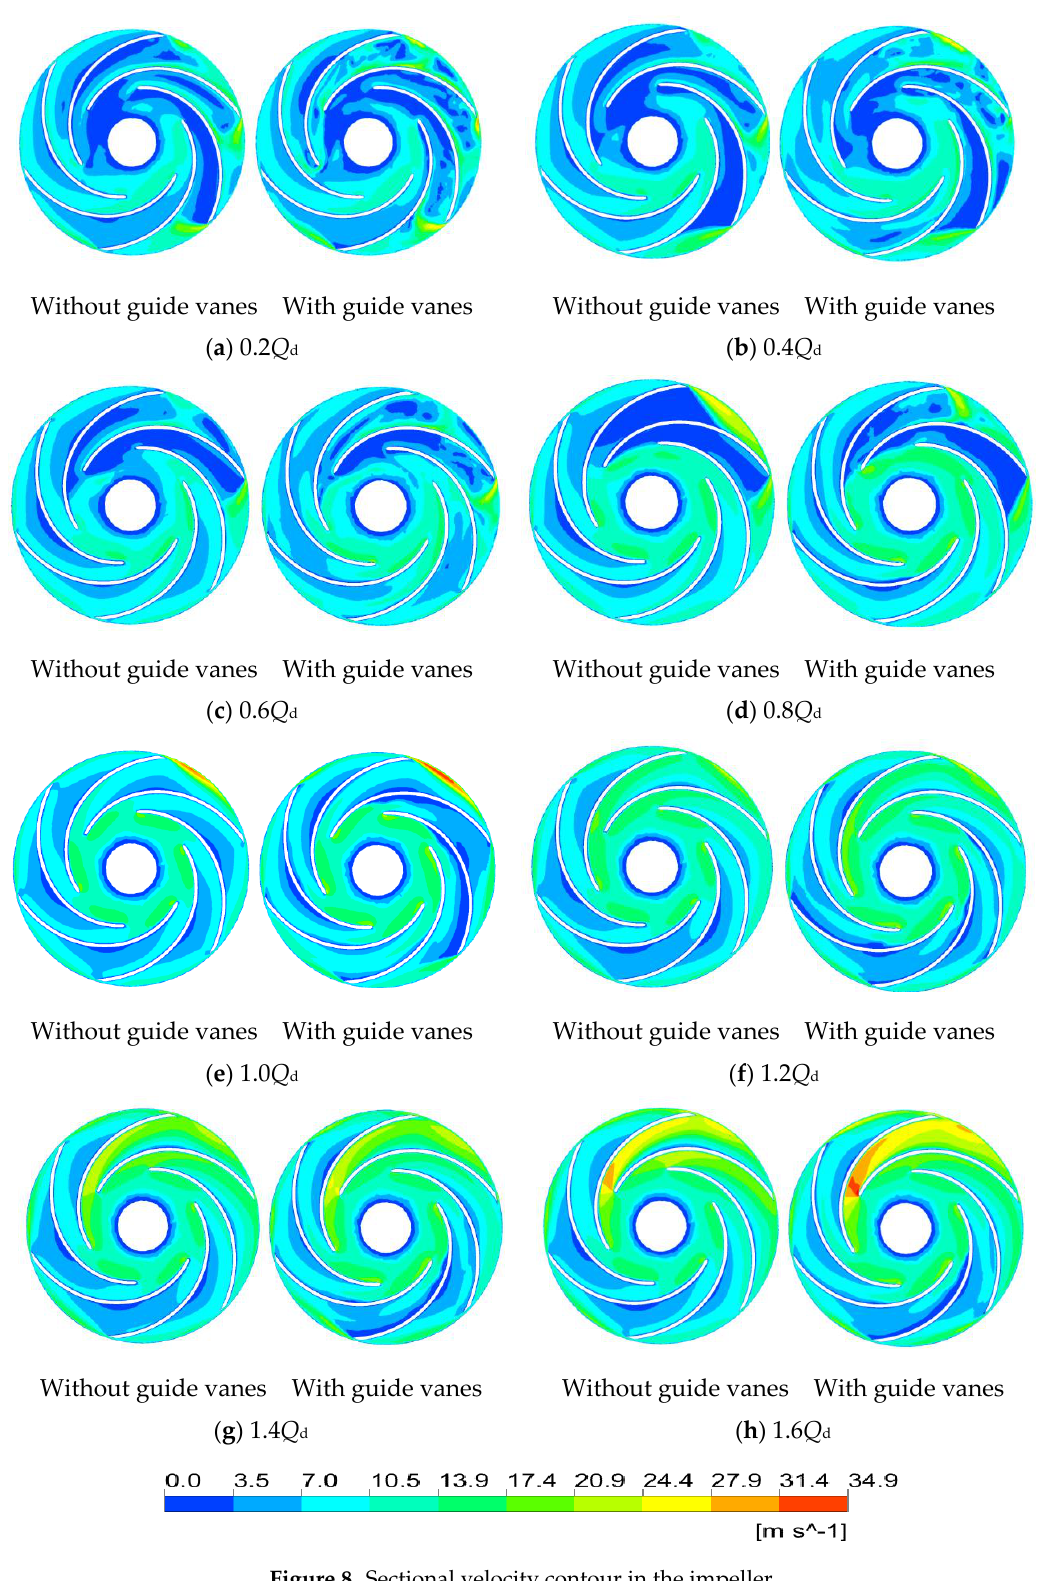
Figure 8. Sectional velocity contour in the impeller.